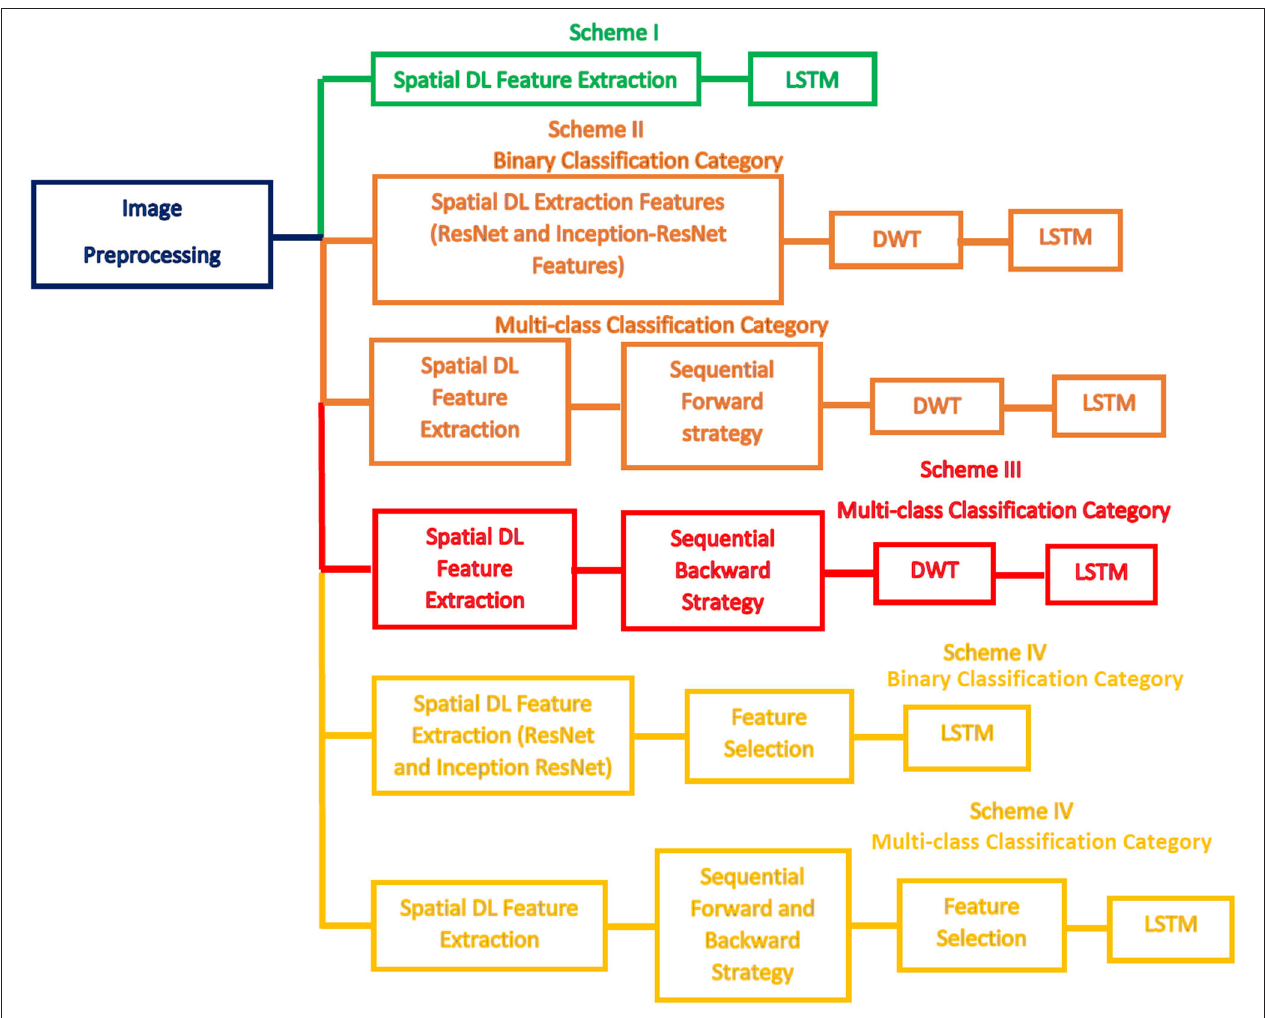
FIGURE 3 | The four schemes of CoMB-Deep.